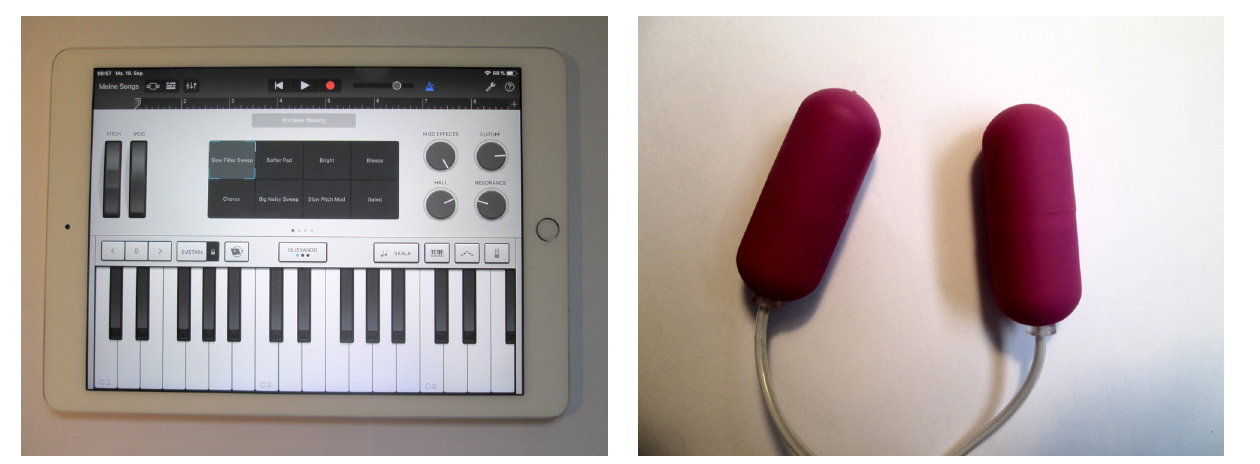
Figure 6: iPad ® Air 2 with app Garage Band.